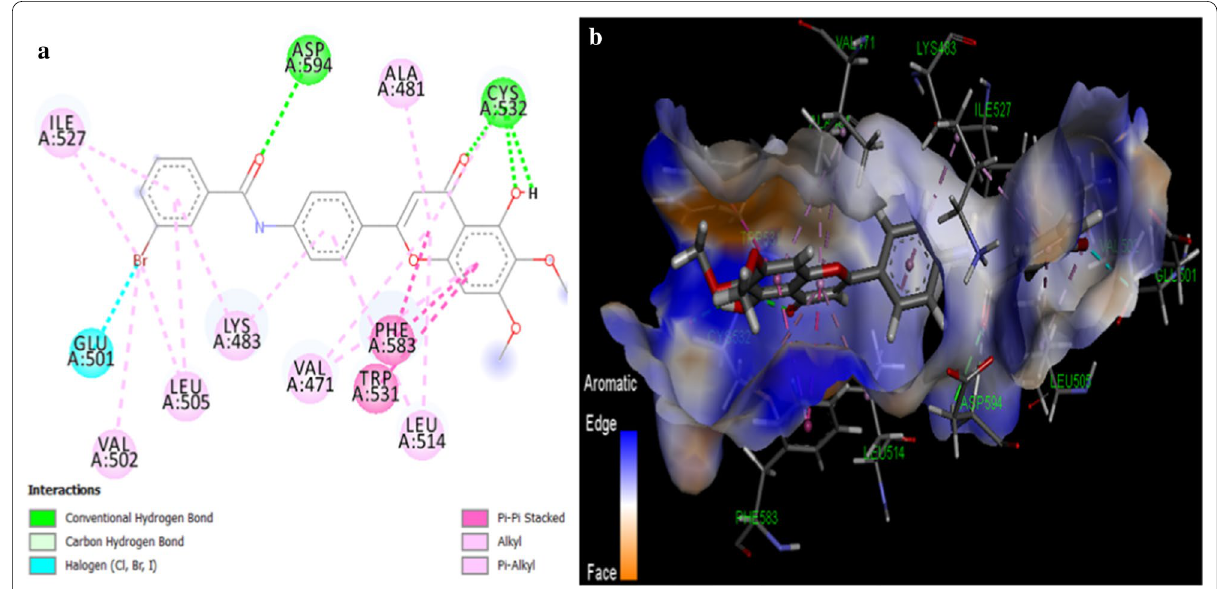
Fig. 1 a 2D diagram for the interaction of compound 28 with V600E-BRAF, b 3D view of the compound 28 in the binding site of V600E-BRAF